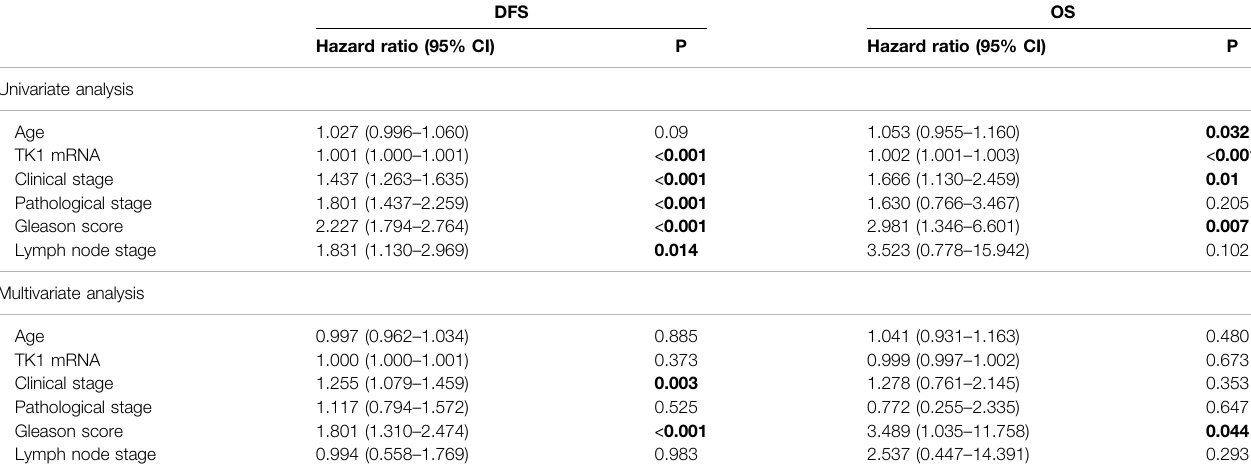
TABLE 4 | Prognostic value of TK1 mRNA expression level for the disease-free survival (DFS) and overall survival (OS) via Cox proportional model.